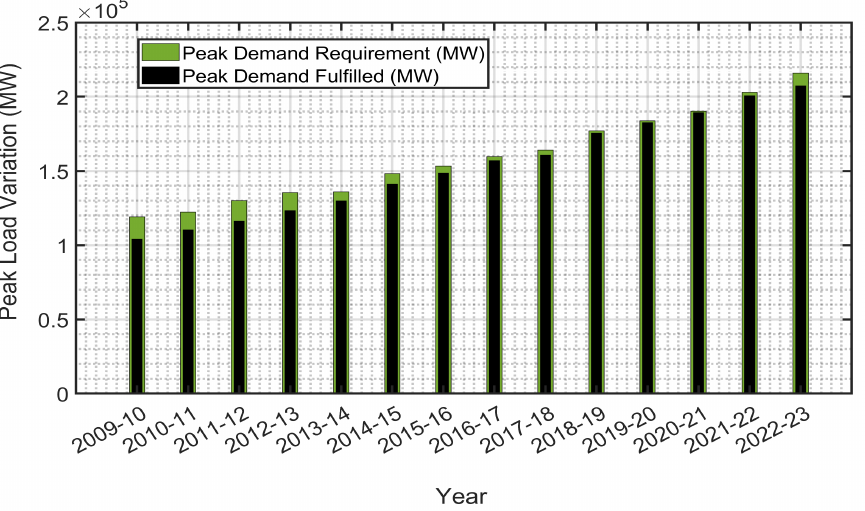
Figure 1. Yearly Peak Demand Requirement versus Peak Demand fulfilled of India in MW. Table 1. Ranges of different prediction horizons for load